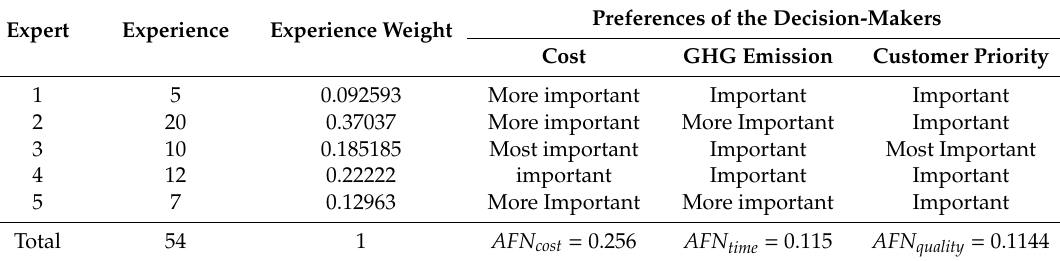
Table 16. Weight determination of each